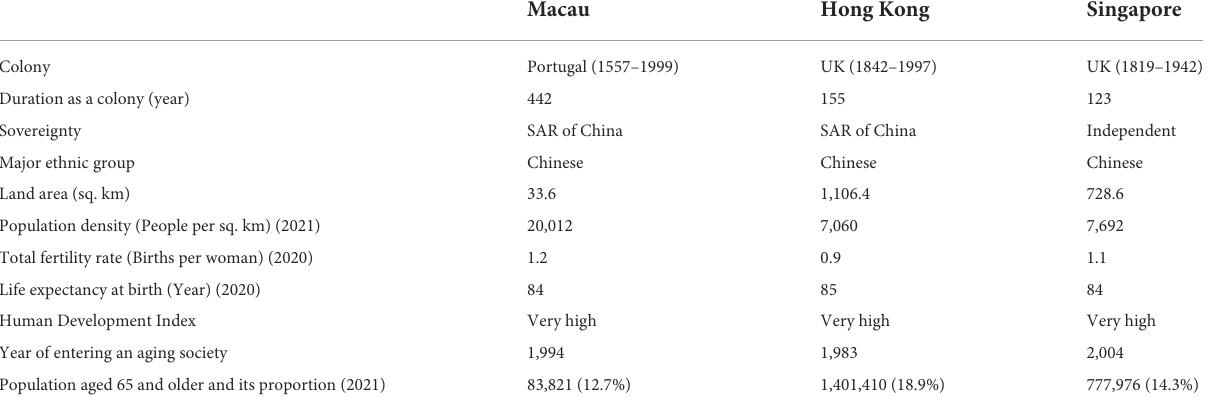
TABLE 1 Basic information about Macau, Hong Kong, and Singapore.